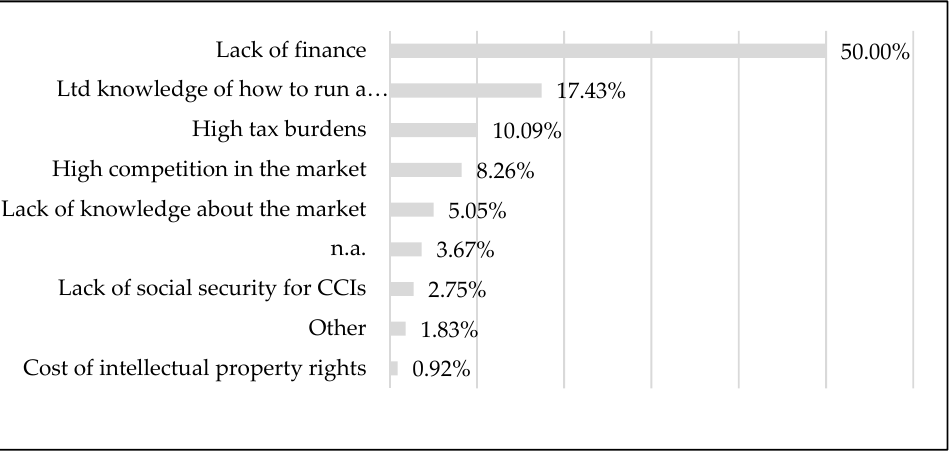
Figure 3. Business-related challenges when starting a company in the CCs. Ranking results Source: Authors elaboration on data collected and shown in TRACES D3.1 deliverable.